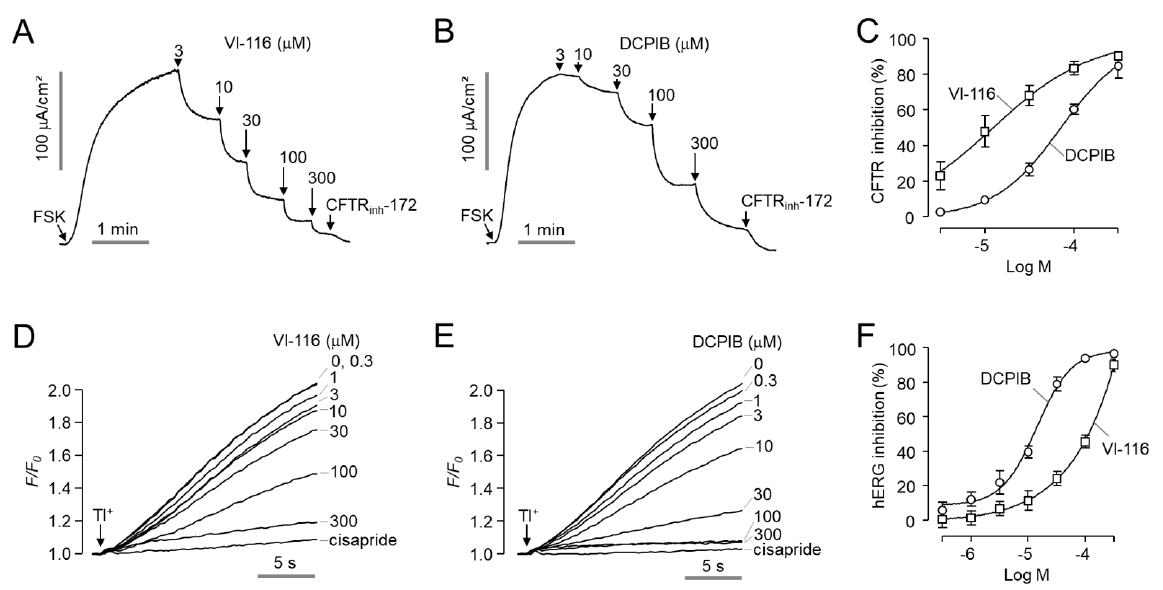
Figure 6. Effects of VI-116 and DCPIB on CFTR and hERG channel activity. ( A , B ) Representative apical membrane currents from 5 independent experiments in FRT cells expressing human CFTR. CFTR was fully activated by 20 μ M forskolin (FSK) and inhibited with indicated concentrations of VI-116 and DCPIB. CFTR was completely blocked by 20 μ M CFTR inh − 172. ( C ) Summary of dose- response (mean ± S.E., n = 5). ( D , E ) The effect of VI-116 and DCPIB on hERG activity was measured using a thallium flux assay in HEK293T cells expressing hERG. Cells were treated with the indicated concentrations of VI-116 and DCPIB for 10 min. hERG channel was activated by application of stimu- lus buffer and was inhibited by 50 μ M cisapride. ( F ) Summary of dose − response (mean ± S.E., n = 6).